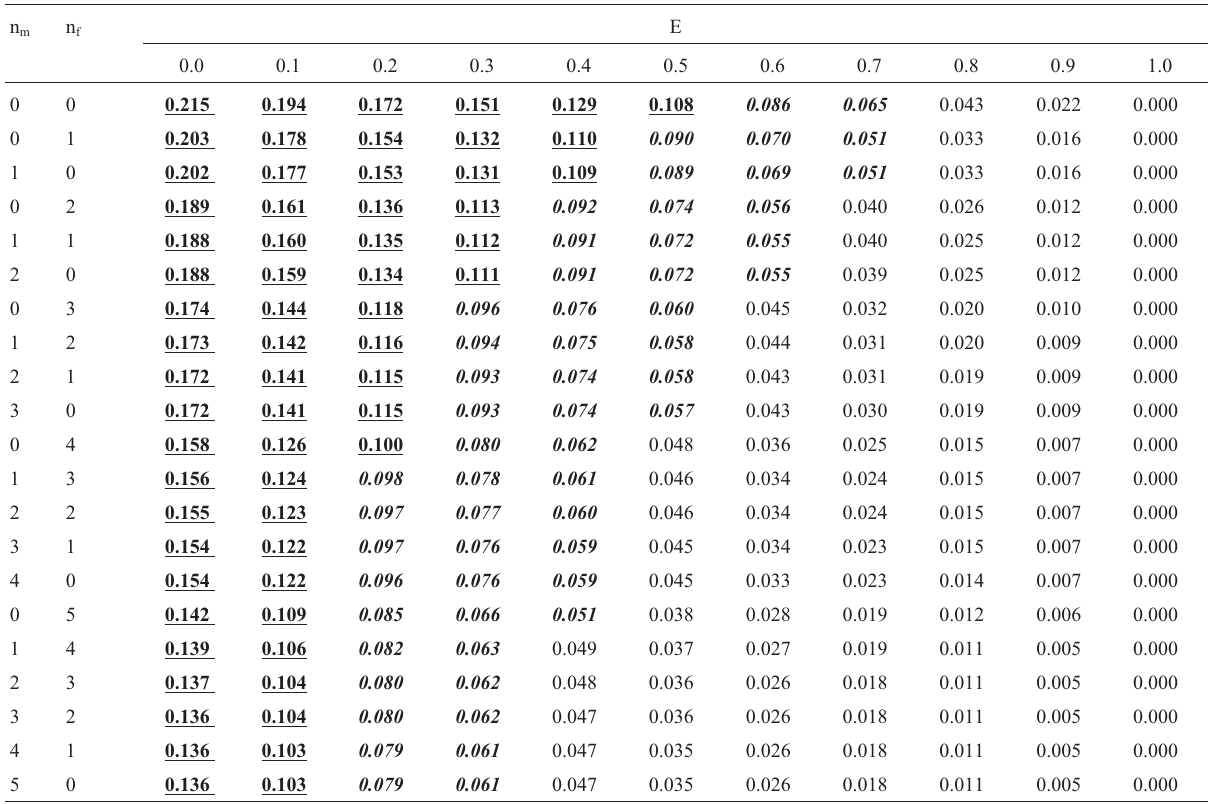
Table 1 - Recurrence risks for a future sib of an isolated case of deafness, as a function of the rate of environmental cases (E) and of the number of normal brothers (n m ) and sisters (n f ) that the affected child already